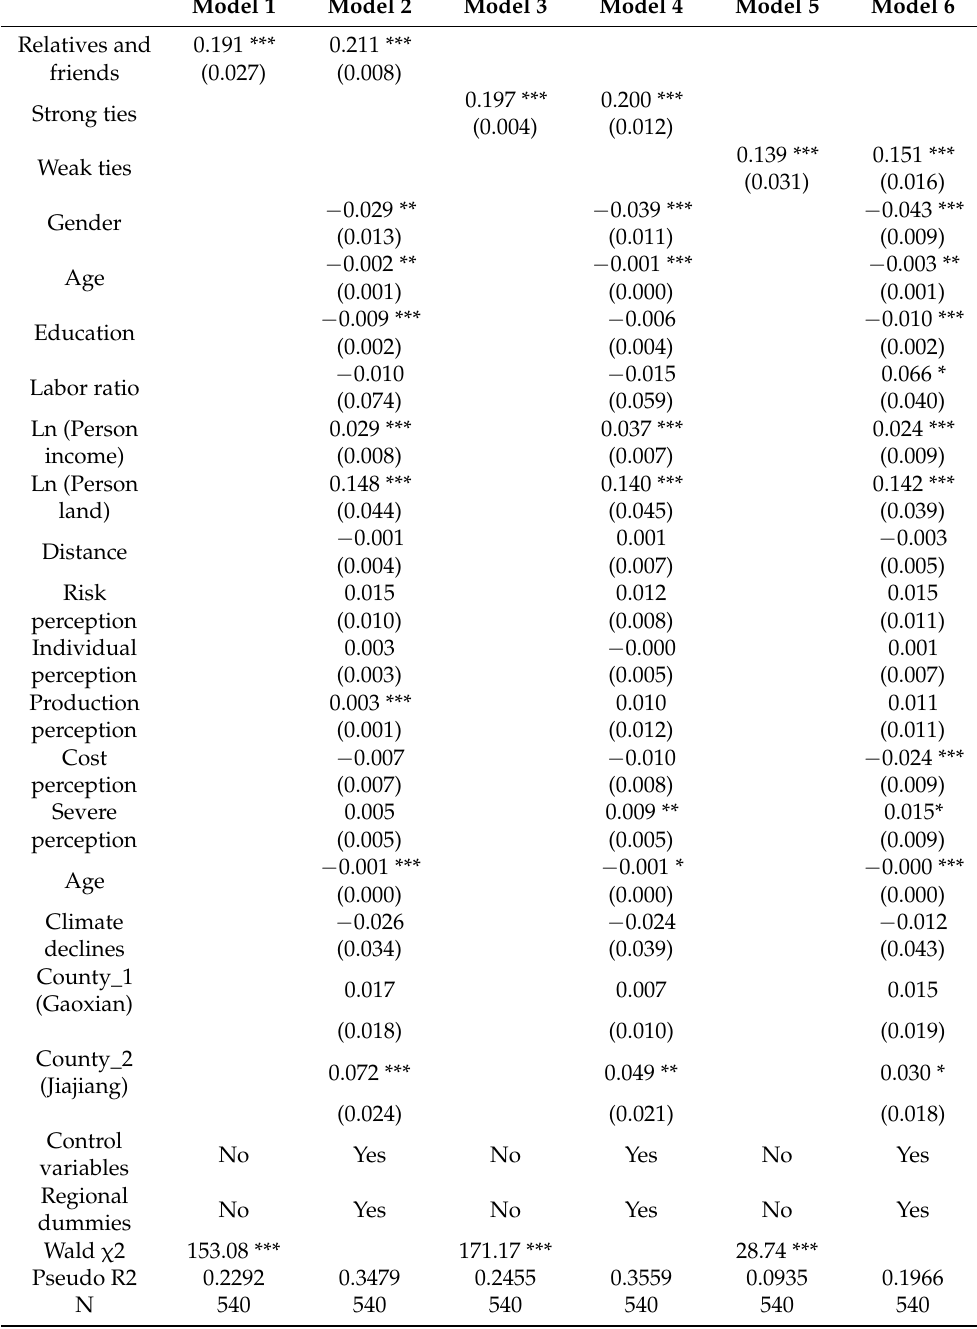
Table 3. Regression results of the binary logistic